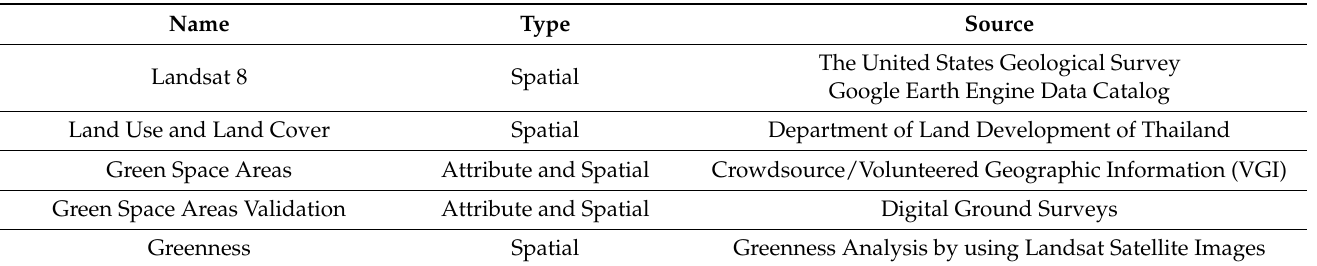
Table 1. Geographical data employed in this study and their